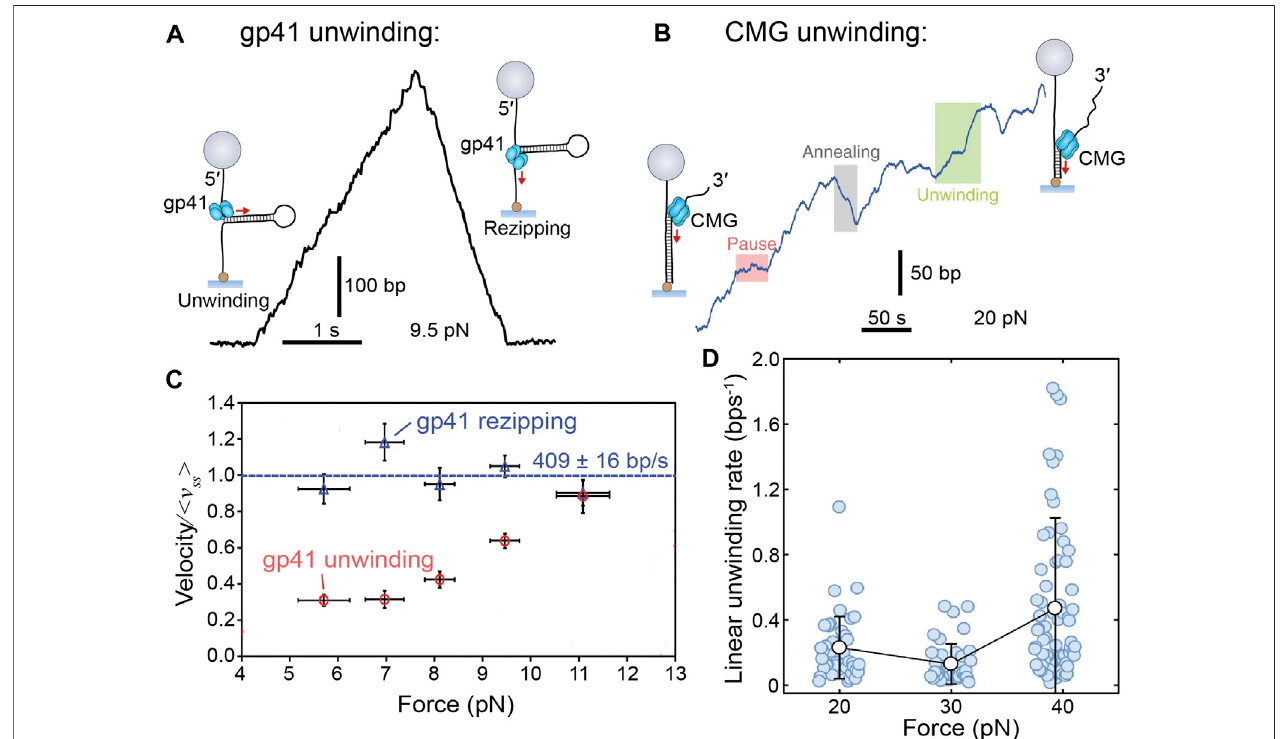
FIGURE4|Single-moleculemanipulationofreplicativehelicaseunwindingevents.(A) MagnetictrapmeasurementofasingleT4gp41helicaseunwinding and rezipping a hairpin DNA template. (B) Asingle CMG unwinding event as measured by a magnetic trap shows more sporadic unwinding, but no rezipping. (C) Gp41 unwindingandrezippingratesmeasuredatdifferentforces.Rezippingisindependentofforce,butequivalenttothessDNAtranslocationrate( < v ss > (cid:1) 409 ± 16bp/s)and unwinding rate increases with force (Ribeck and Saleh, 2013). (D) CMG unwinding rate also increases with force but with a less obvious trend (Burnham et al.,